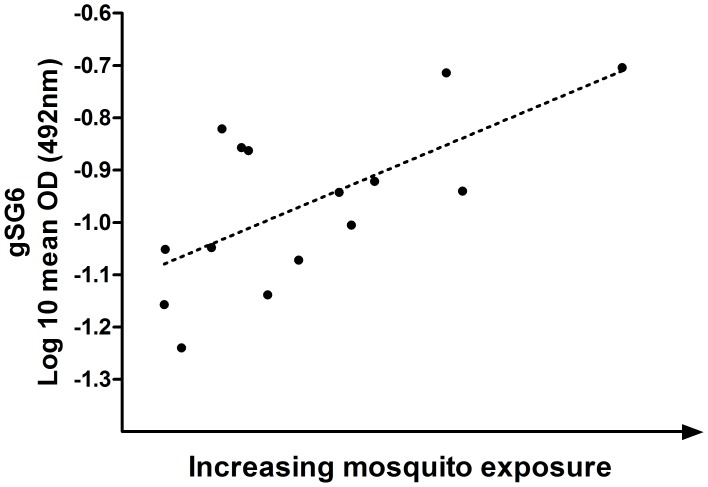
Mean anti-gSG6 IgG level per subvillage, plotted against increasing mosquito exposure per subvillage.Anti-gSG6 IgG levels are given as the log-10 adjusted mean anti-gSG6 OD per subvillage. Mosquito exposure is given as the ascending and sequential mean Anopheles female count for each of 15 subvillages (x-axis), as in
Figure 2
. The trend-line from the linear regression is shown as a dashed line (r2 = 0.436, p = 0.007).